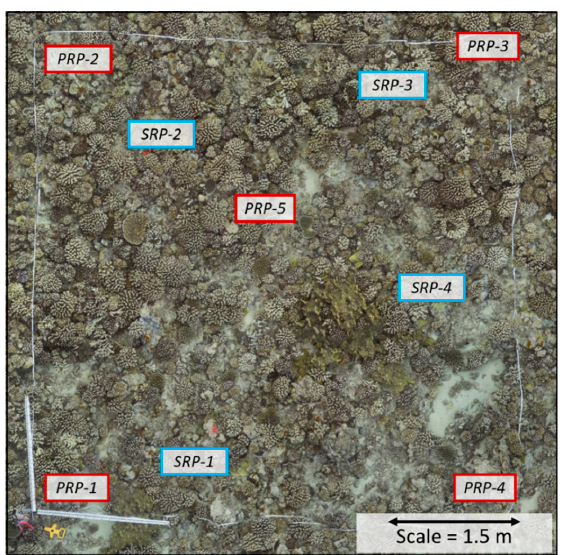
Figure 5. Orthographic view of one of our 5 × 5 m fore reef plots with primary (red) and secondary (blue) reference points, testing site for the five different camera systems.